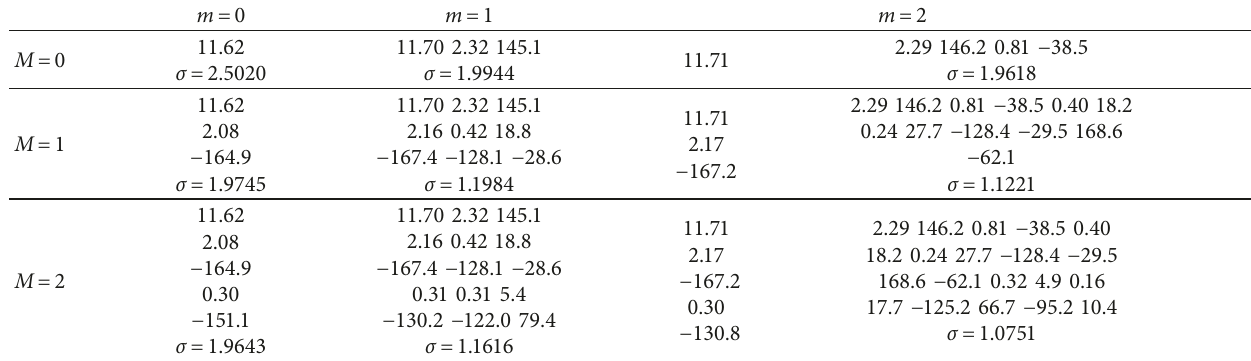
Table 4: Yearly matrices p � 0, 1, 2 and M � 0, 1, 2. e for m m � 0 m � 1 m � 2 M �